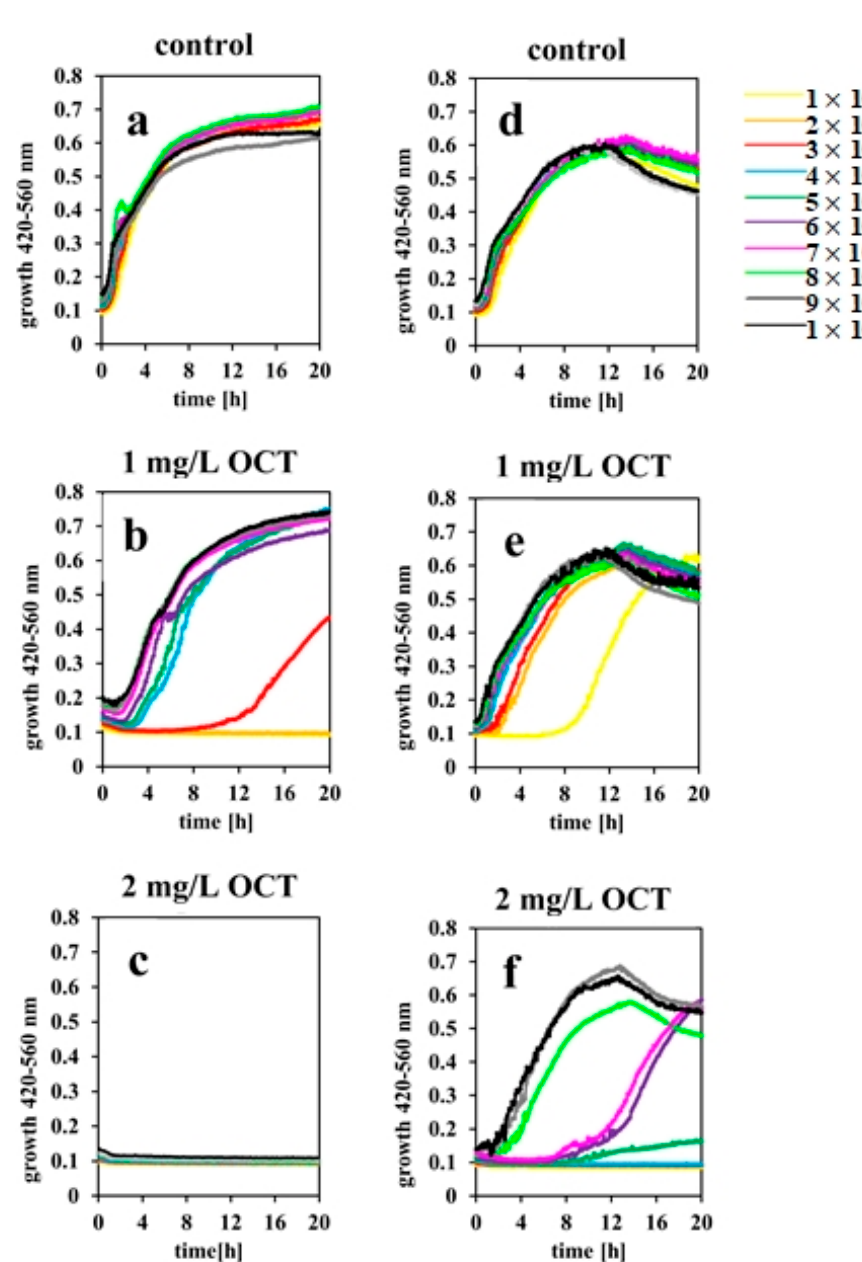
Figure 2. Inhibition of E. coli wildtype growth is strongly influenced by OCT water concentration and initial bacterial load. Growth curves of inoculum of 1 × 10 7 –1 × 10 8 cells/mL or CFU/mL as measured directly by QUANTOM TM technology ( a – c ) or optical density following the recalculation of CFU/mL by colony counting on agar plates ( d – f ), respectively. Bacterial growth in the absence ( a , d ) and presence of indicated OCT concentrations ( b , c , e , f ) over 20 h as recorded by Bioscreen at 420–560 nm. The results are representative data of at least three independent